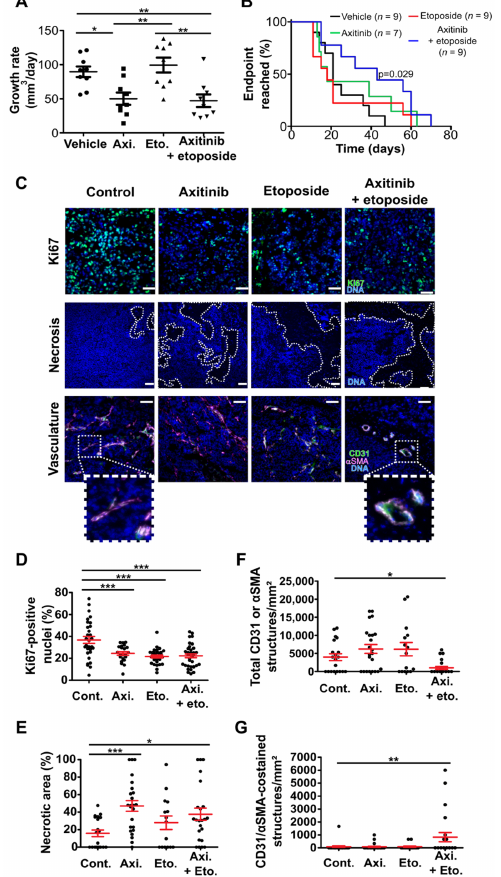
Figure 5. Axitinib and axitinib/etoposide combination treatments reduce subcutaneous HD-MB03 tumor growth and cell proliferation, induce necrosis and tumoral fibrosis and impair tumor vascu- larization. ( A ) Dot plots showing the growth rate of individual subcutaneous tumors treated with the indicated compounds (horizontal lines and error bars represent the means ± SEM; ** p < 0.01, * p < 0.05, one-way ANOVA test, the results are statistically nonsignificant unless otherwise stated). ( B ) Curves presenting the proportion of mice reaching the endpoint volume of the tumor as a function of time after tumor implantation (black: control treatment; green: axitinib treatment; red: etoposide treatment; blue: axitinib/etoposide combined treatment; the p -value of a logrank test comparing the control and axitinib/etoposide groups is indicated; all the other comparisons were not statistically significant; all the data presented were pooled from two strictly independent experiments and the total number of animals for each group is indicated in brackets). ( C – G ) Histological analysis of sub- cutaneous HD-MB03 xenografts. ( C ) Representative images of the sections of tumors treated with the indicated compounds: proliferative cells revealed by Ki67 immunofluorescent staining (green) and Hoechst33342 nuclear DNA counterstaining (blue); necrosis revealed by DNA counterstaining (blue) (dotted lines delineate necrotic areas); vasculature revealed by CD31 and α SMA immunofluorescent staining (green and magenta, respectively) and Hoechst33342 nuclear DNA counterstaining (blue) (images are representative of at least four independent tumors, scale bars: 100 µ m). ( D ) Dot plot representing the quantification of the proportion of Ki67 positive nuclei in the indicated experimental conditions. ( E ) Dot plot representing the quantification of the proportion of necrotic area in the indicated experimental conditions, ( F ) the number of CD31 and/or α SMA structures per µ m 2 and ( G ) the number of functional blood vessels per mm 2 (bars represent the means ± SEM; *** p < 0.001, ** p < 0.01, * p < 0.05, one-way ANOVA